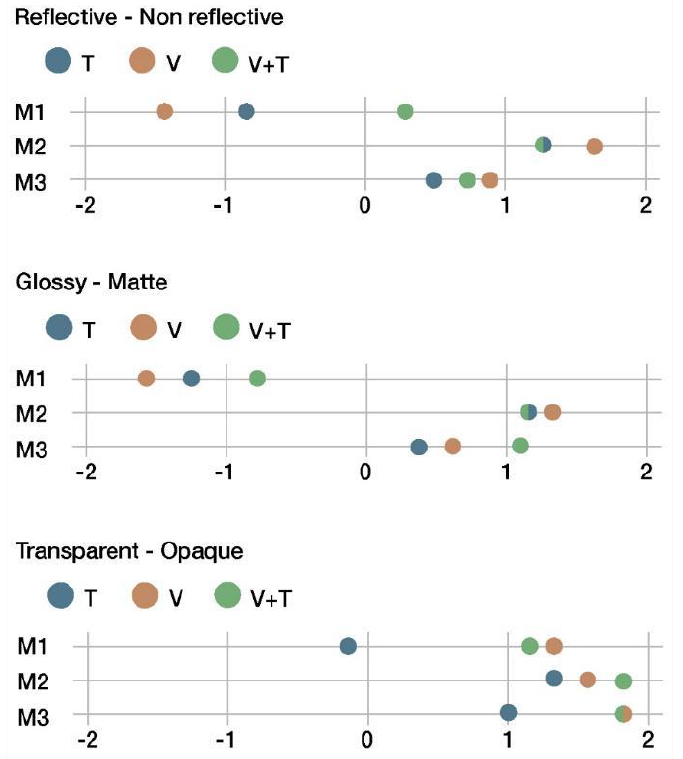
Figure 12. First cluster of sensorial properties.